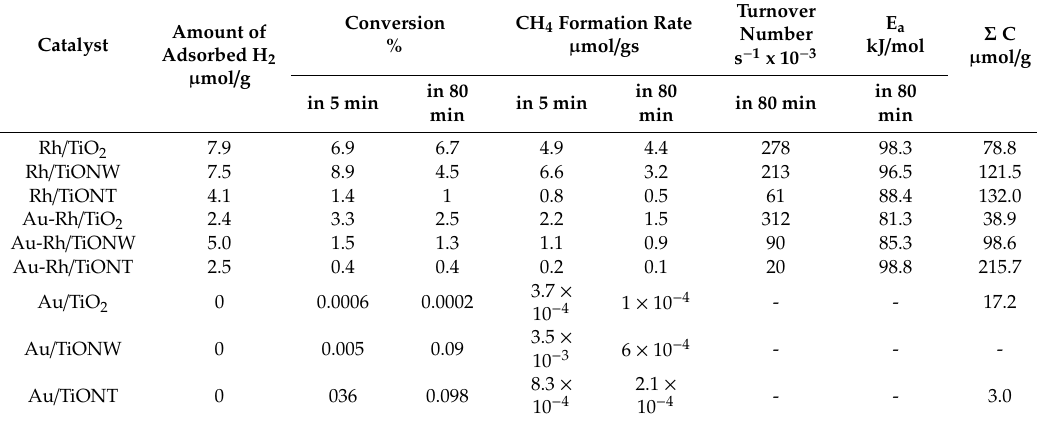
Table 2. Characteristic data for hydrogenation of carbon dioxide over Rh, Au, Au–Rh bimetallic clusters supported on titanate nanotubes, nanowires and TiO 2 . The reaction temperature was 493 K.